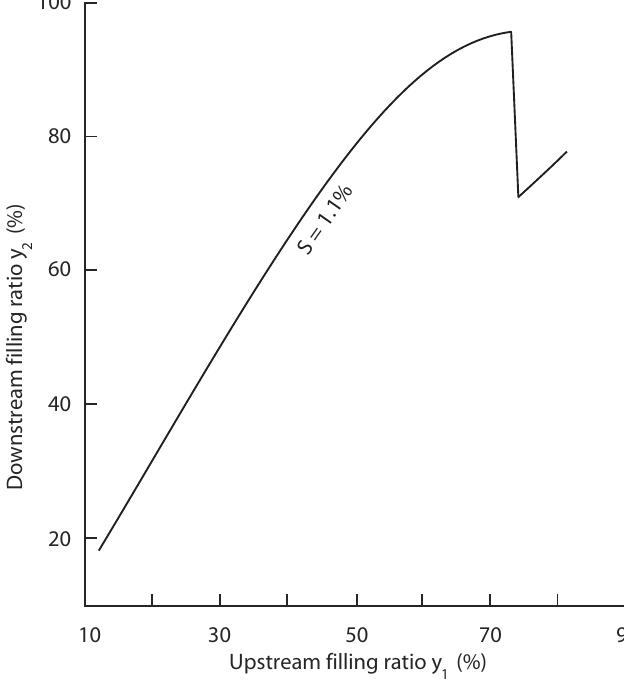
Figure 10. Change of the filling ratio, y 2 , after a hydraulic jump with increasing upstream filling ratio, y 1 , before the jump. The sudden drops in y 2 indicate a transition from the direct hydraulic jump to the undular hydraulic